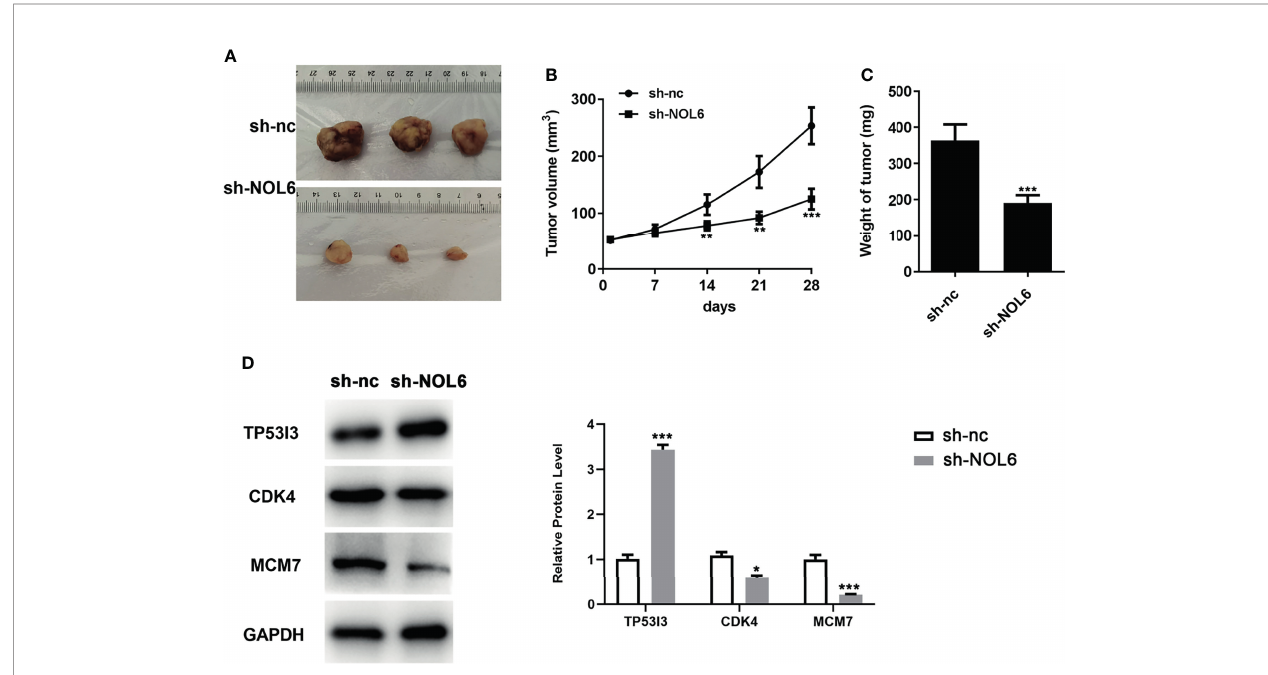
FIGURE 9 | Effect of NOL6 silencing on the growth of tumor in the nude mice. (A) The image of the tumor. (B) Effect of sh-NOL6 on the volume of the tumors in the mice. (C) Effect of NOL6 silencing on the weight of the tumors in the mice. (D) Expressions of TP53I3, CDK4 and MCM7 in different groups (*p < 0.05, **p < 0.01, ***p < 0.001 v.s.